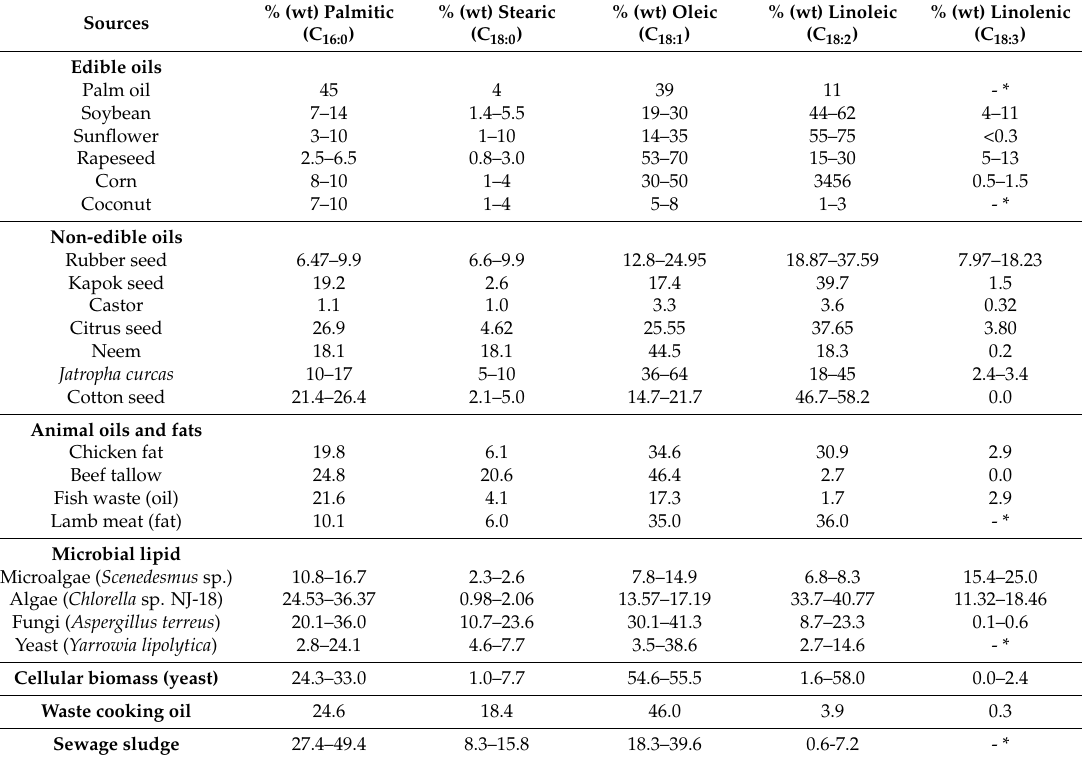
Table 7. Percentage of fatty acids in various raw materials